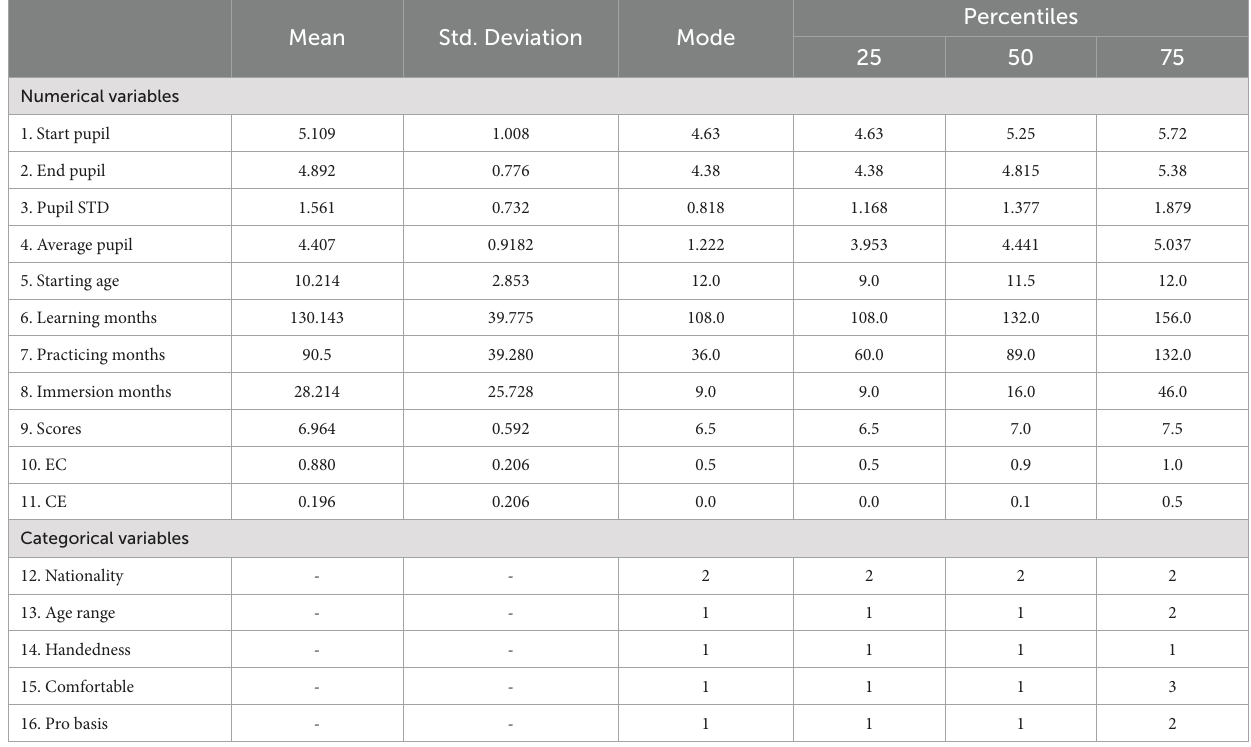
TABLE 1 Descriptive statistics of the 16 predicting